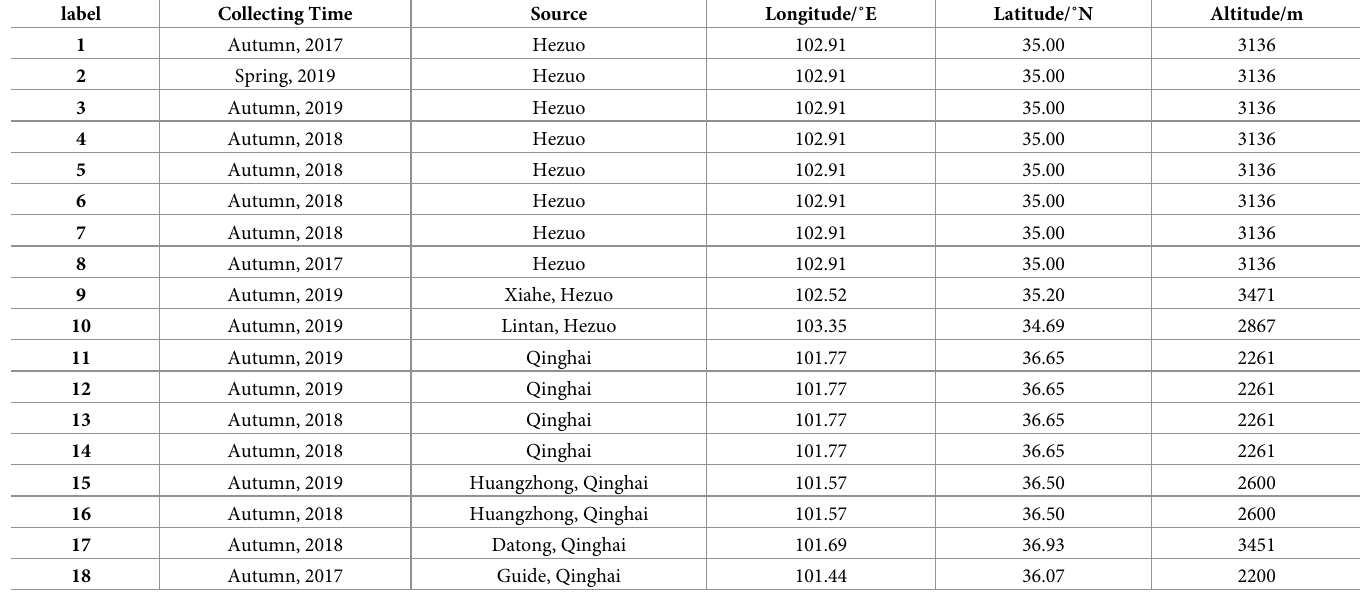
Table 1. Rheum tanguticum sample